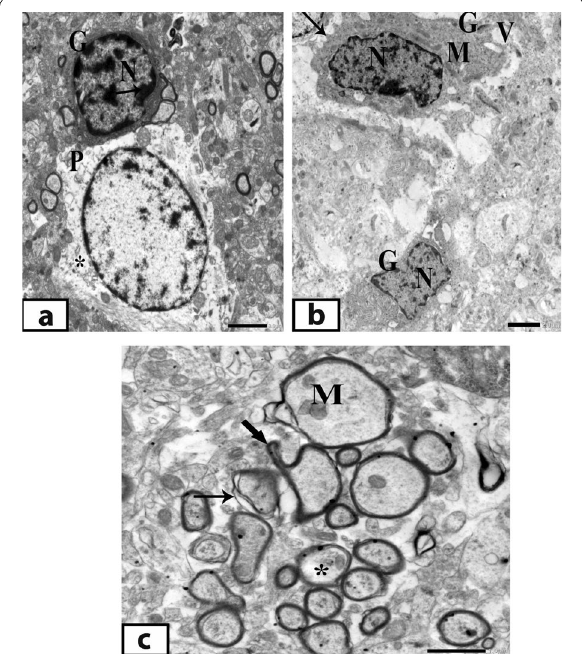
Fig.8 Electron micrographs of the cerebral cortex obtained from the reserpine-treated rats showing a : degenerated pyramidal cell (P) with rarified cytoplasm (*) and a granular neuron with shrunk nucleus (N) and severe clumping chromatin (arrow), b : showing apoptotic granular cells (G) had shrunk nuclei (N), apoptotic blebs (arrow), the cytoplasm contained numerous degenerative vacuoles (V), and mitochondria (M). c : showing degenerated nerve axons (thin arrow), with splitting or discontinuity of myelin sheath (thick arrow), rarified axoplasm (*), and dense mitochondria